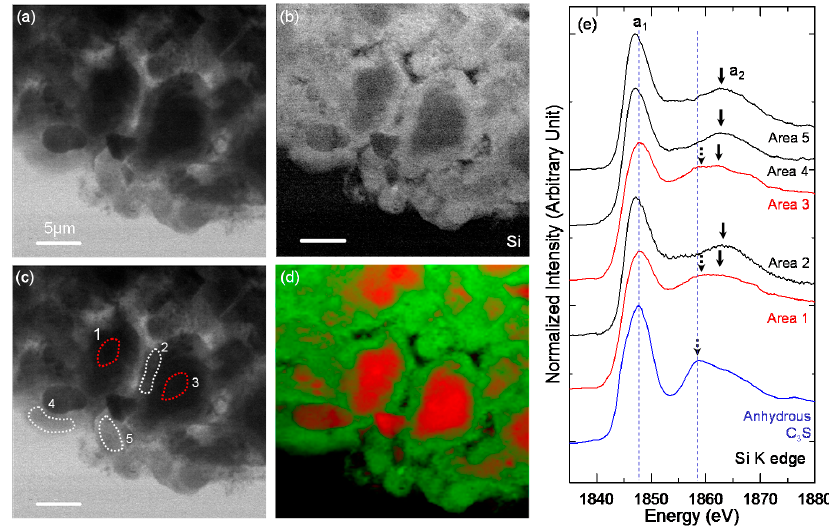
Figure 7. The STXM results of C-28d. ( a ) Single image taken at 1840 eV; ( b ) Si image contrast map; ( c ) areas selected for Si NEXAFS analysis (Area 1 and 3: core area; Area 2, 4 and 5: C–S–H layer); and ( d ) RGB overlay maps assessed by using the spectra obtained from Area 1 ( red ) and Area 2 ( green ), shown in ( e ).